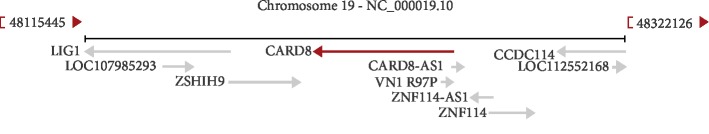
Schematic diagram of CARD8 gene location.